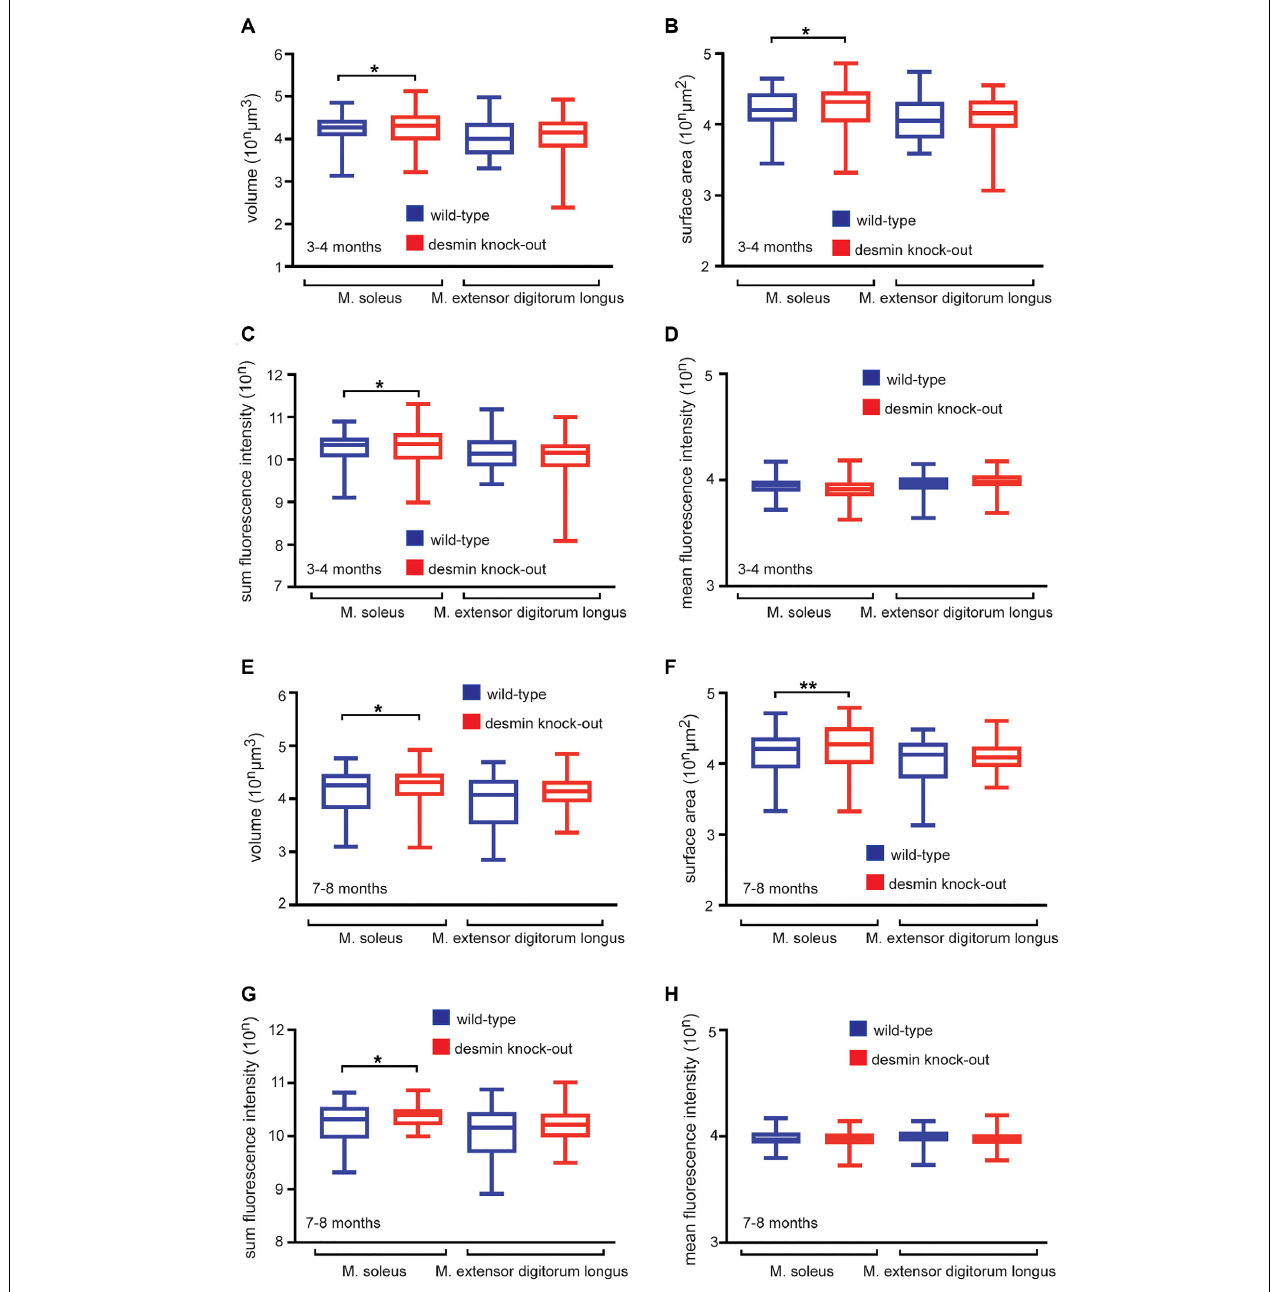
FIGURE 4 | Desmin knock-out mice display enlarged NMJs in soleus muscle. (A–D) Hindlimb muscles of 3–4 months old wild-type and homozygous desmin knock-out mice were dissected to stain fiber bundles with BTX. Imaging was done with a fluorescence microscope, and z-stacks were acquired for quantitative 3D morphometry. (A–D) Box and Whisker plots depict the recorded average volume, surface, and sum fluorescence intensity per NMJ of indicated genotypes and muscles. Note, surface, volume, and sum fluorescence intensity of NMJs are significantly higher in homozygous desmin knock-out mice in soleus muscle in comparison to wild-type littermates. For extensor digitorum longus muscle a total of 96 wild-types and 89 homozygous NMJs, for soleus muscle 90 wild-type and 103 homozygous NMJs were counted ( n = 3 mouse pairs). Statistical significance was determined by unpaired two-tailed t -test (* P < 0.05). (E–H) Hindlimb muscles of 7–8 months old wild-type and homozygous desmin knock-out mice were dissected to stain fiber bundles with BTX. Imaging was done with a fluorescence microscope, and z-stacks were acquired for quantitative 3D morphometry. (E–H) Box and Whisker plots depict the recorded average volume, surface, and sum fluorescence intensity per NMJ of indicated genotypes and muscles. Note, surface, volume, and sum fluorescence intensity of NMJs are significantly higher in homozygous desmin knock-out mice in soleus muscle in comparison to the controls. For extensor digitorum longus muscle a total of 102 wild-types and 95 homozygous NMJs, for soleus muscle 99 wild-type and 102 homozygous NMJs were counted ( n = 3 mouse pairs). Statistical significance was determined by unpaired two-tailed t -test (* P < 0.05, ** P <